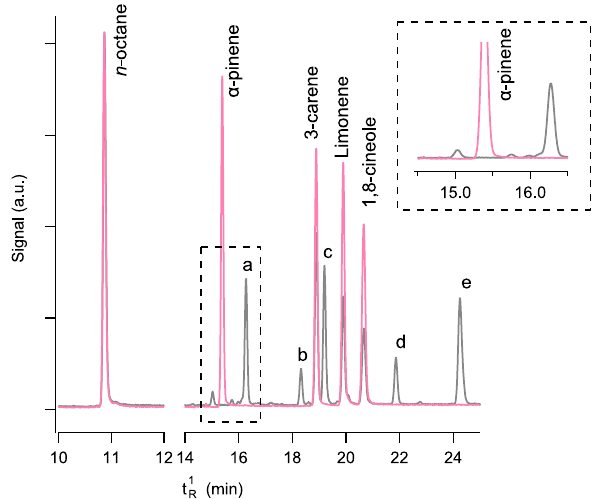
Figure 4. Typical chromatograms for a stable (pink) and an un- stable (grey) terpene mixture. The nominally 2nmolmol − 1 refer- ence PRM, mixture BB (shown in pink) in an Air Products Experis cylinder was made from the same parent PRM as the PRM made in the internally passivated BOC SPECTRA-SEAL cylinder (shown in grey). The SPECTRA-SEAL cylinder was analysed less than 24h after preparation and shows significant degradation of the terpene compounds. The zoomed in portion of the chromatogram focuses on the α -pinene peak (inset), showing that all of this compound has been lost. The additional peaks observed in the analysis of the SPECTRA-SEAL passivated cylinder, labelled as a–e, correspond to those named in the main text and to the observed MS shown in Fig. S1.